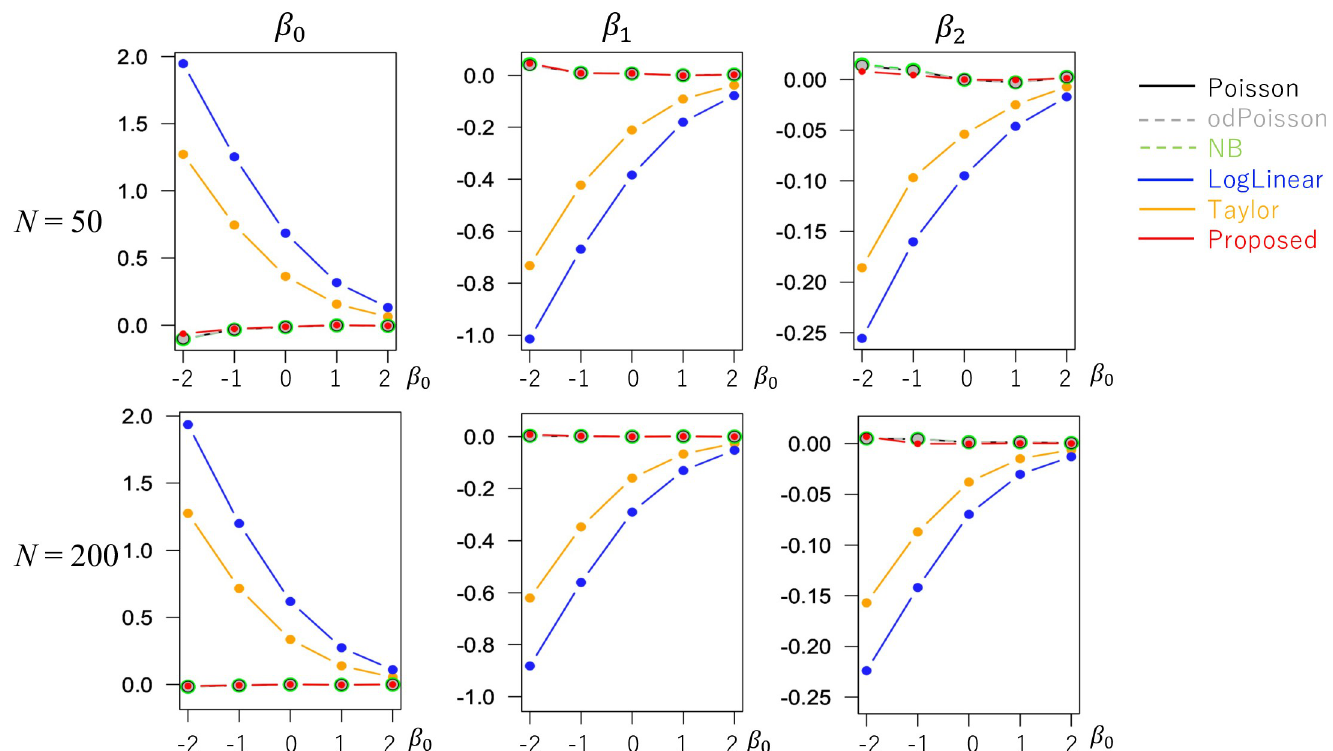
Fig 2. Bias of the regression coefficients in cases without overdispersion ( σ 2 = 1.0) (x − axis: β 0 , y-axis: Bias).